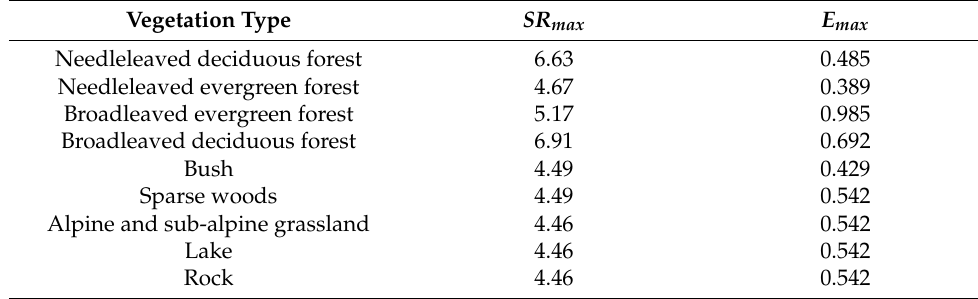
Table 1. The maximum light energy utilization efficiency ( E max ) of typical vegetation